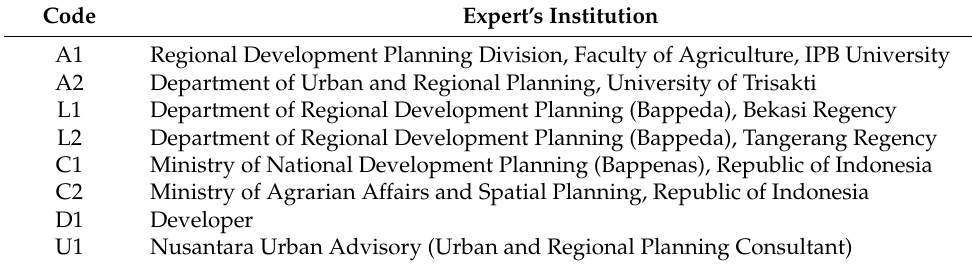
Table 3. List of experts for the